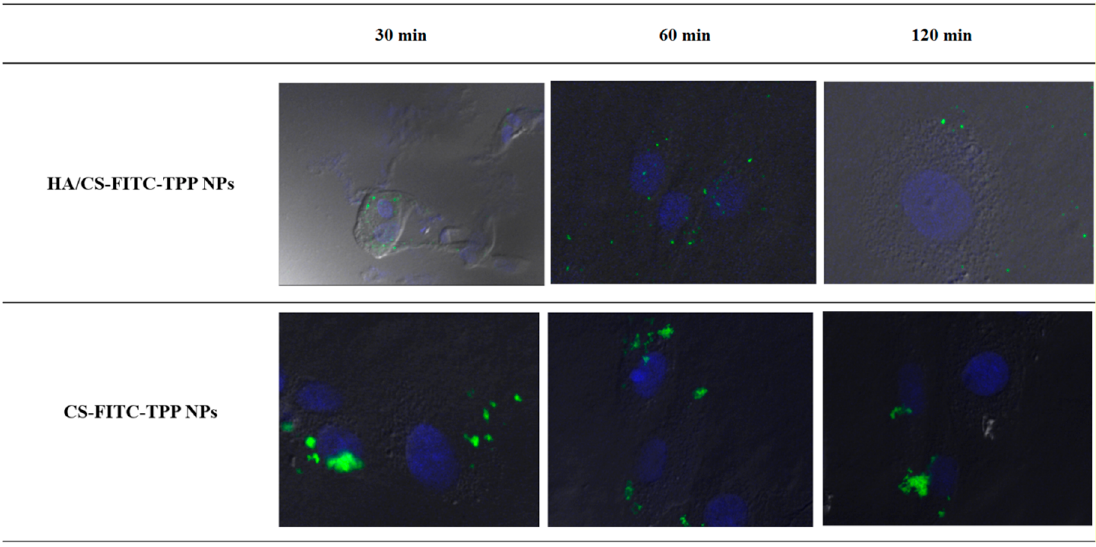
Figure 8. Confocal microscopy images of NHDFs (# 100,000 cells) incubated with HA/CS-FITC-TPP NPs and CS-FITC-TPP NPs at scheduled times (30, 60, and 120 min). Green excitation signals for HA/CS-FITC-TPP NPs and CS-FITC-TPP NPs, and blue excitation signals for cells nuclei. Magnification 63×.